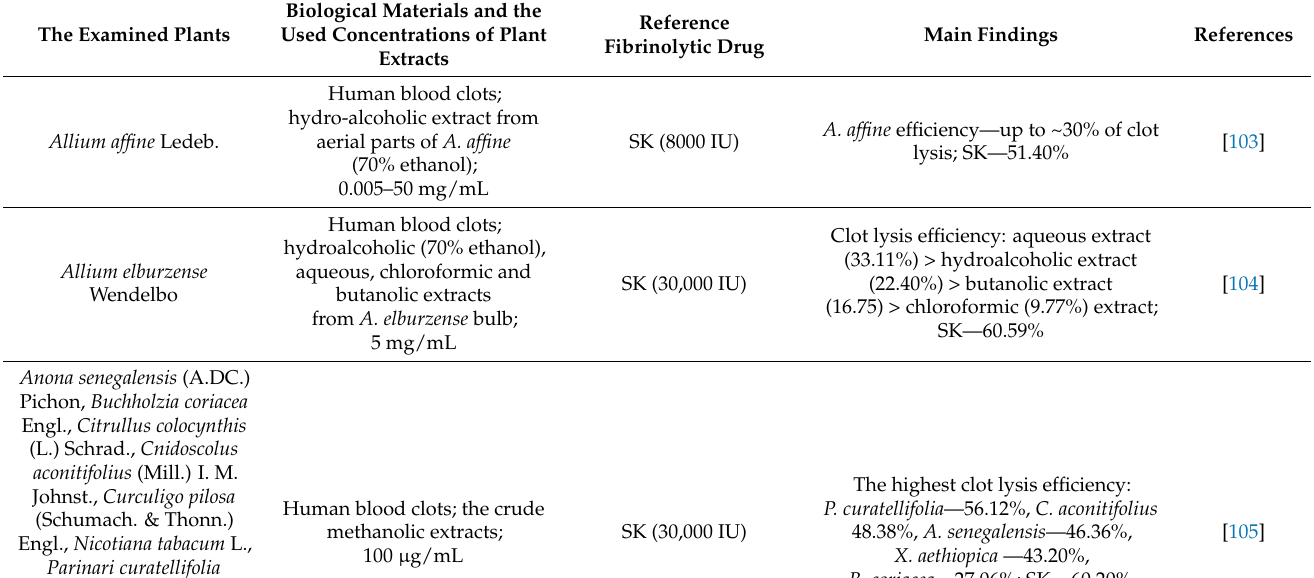
Table 5. Exemplary data from in vitro studies on effects of plant-derived preparations on fibrin clot lysis.